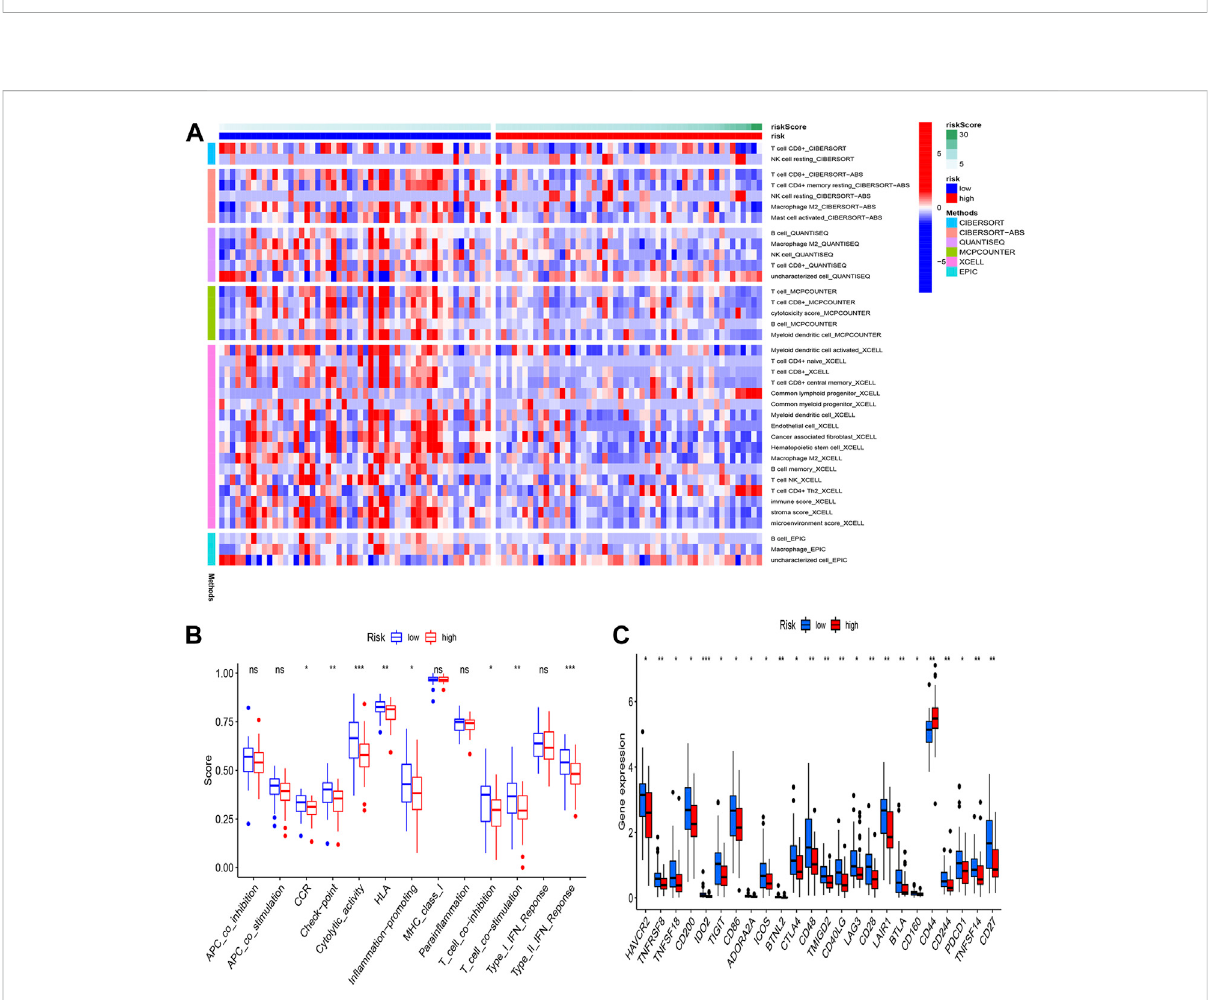
FIGURE 6 Immunoassay analysis. (A) Immune cell in fi ltration distribution. The distribution of immune cells was signi fi cantly different between the high- and low-risk groups. (B) Immune-related functions. (C) The expression of immune checkpoint-related genes.